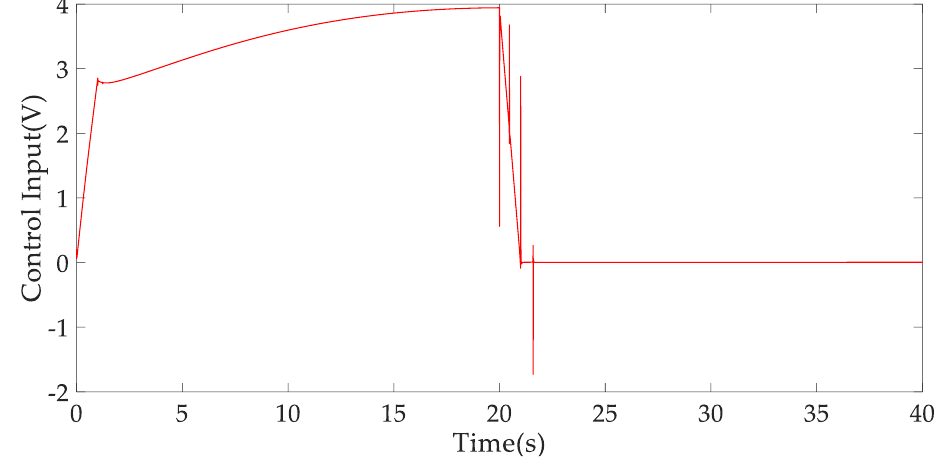
Figure 4. The tracking errors of four controllers.